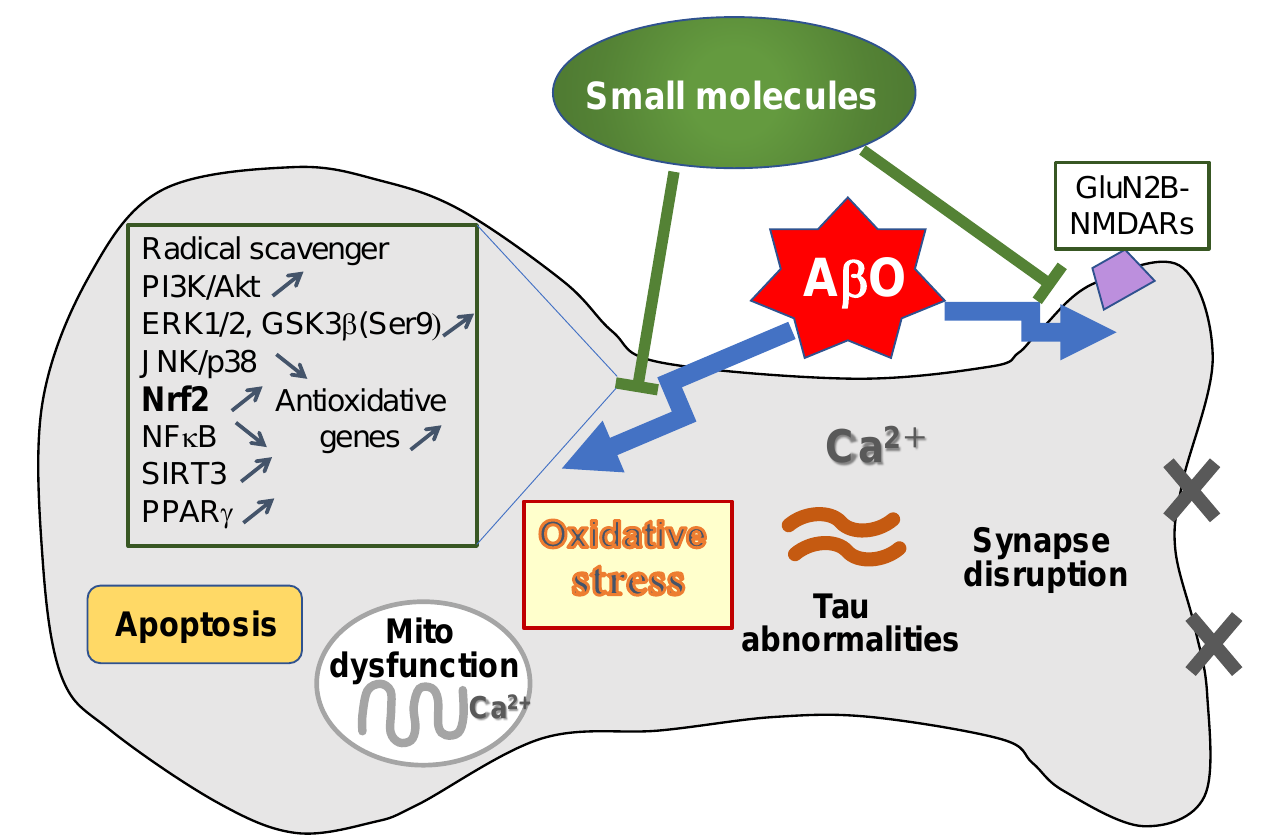
Figure 2. Mechanisms of action of small molecules with A β O-neurotoxicity-reducing effects. A β Os induce various pathological abnormalities, including oxidative stress, Ca 2+ dyshomeostasis, mito- chondrial (mito) dysfunction, apoptosis, synaptic disruption, and tau abnormalities, leading to cogni- tive impairment. These responses are ameliorated by application of the antioxidative small molecules described in the text. These molecules exert ameliorative effects through various mechanisms, includ- ing activation of PI3K/Akt and Nrf2 pathways, inhibition of the JNK/p38 pathway, and